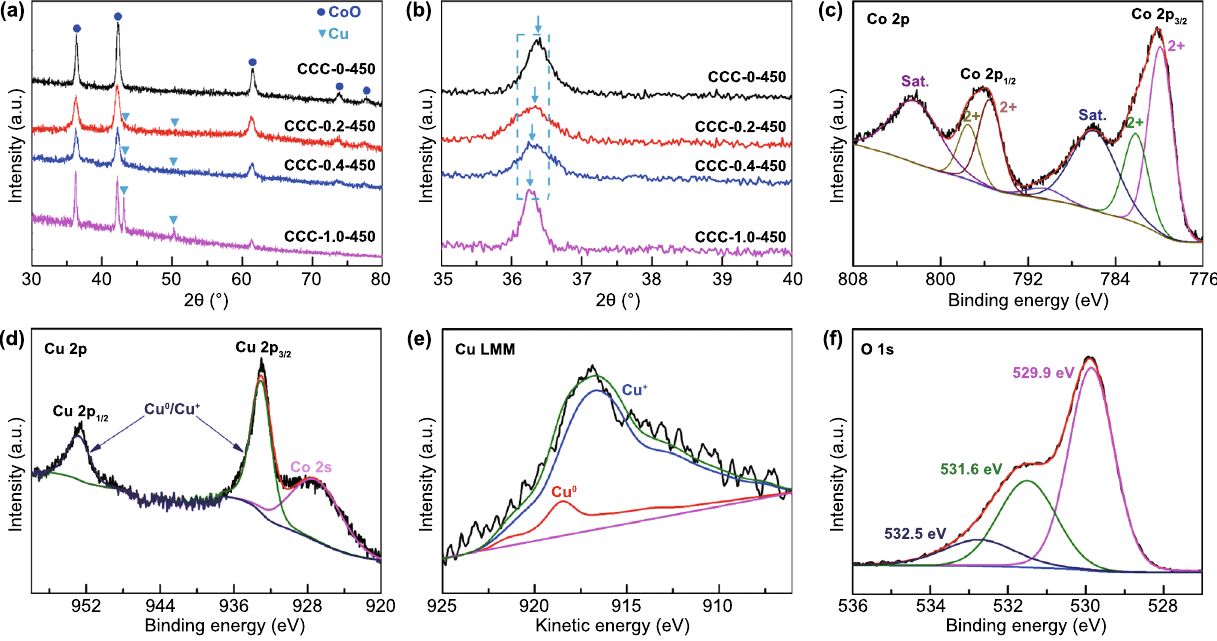
Fig. 1 a , b XRD patterns of the as-prepared CCC-M-450 ( M = 0, 0.2, 0.4, 1.0) samples. XPS spectra of CCC-0.2-450: c Co 2 p , d Cu 2 p , e Cu LMM, f O 1